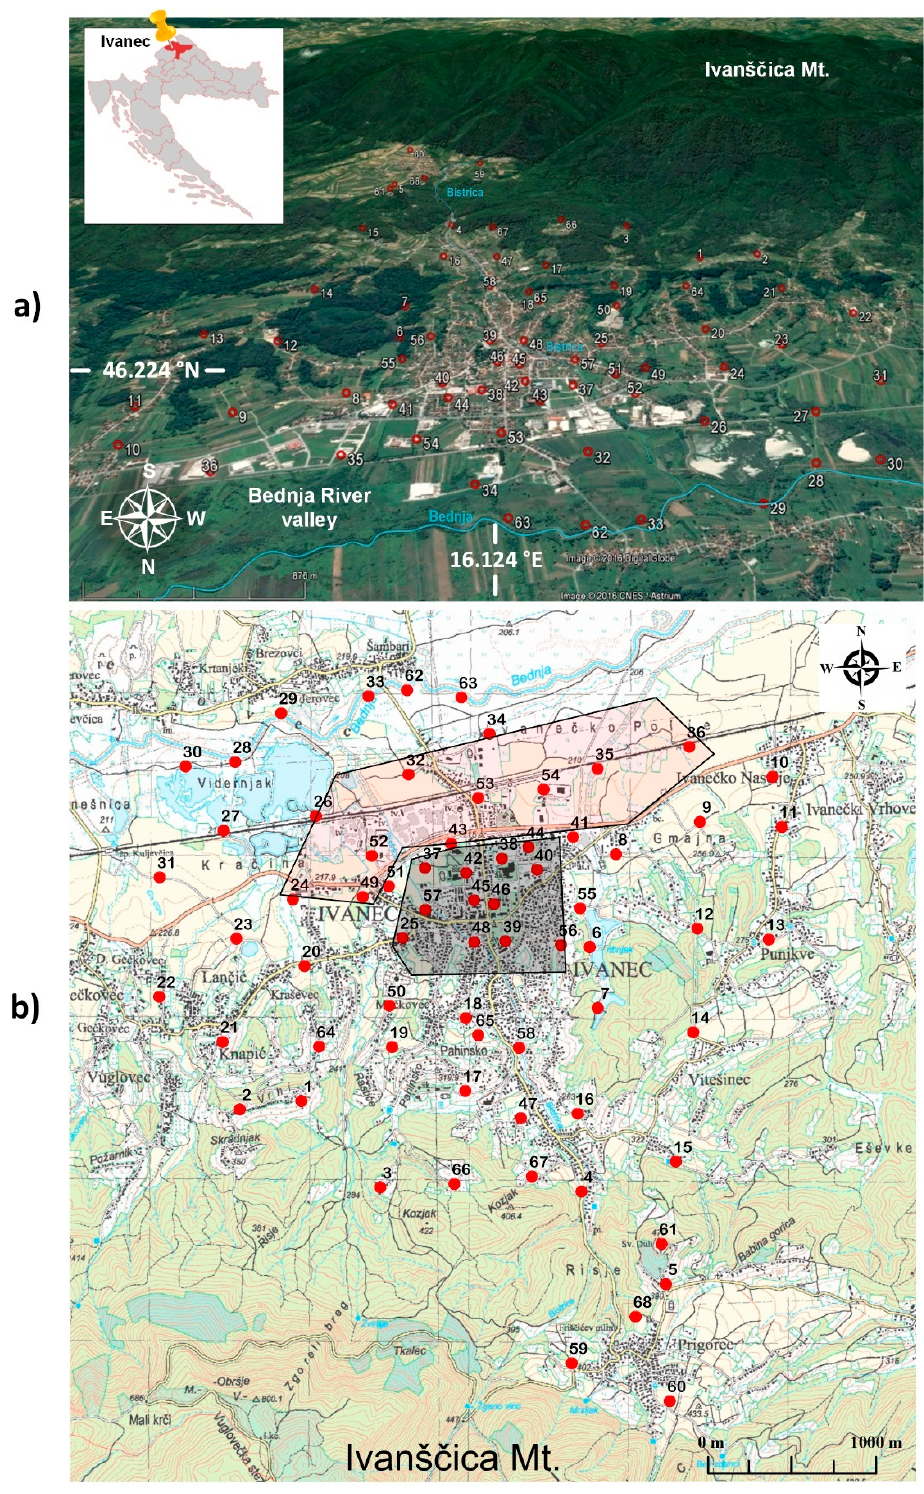
Figure 1. ( a ) Location of the City of Ivanec between Bednja River valley and Mt. Ivanš č ica. Figure is oriented to South direction to better perceive topographic terrain of the studied area and transition from Bednja River valley towards foothills of the Mt. Ivanš č ica. ( b ) Topographic map of the City of Ivanec. Red circles indicate microtremor measurement locations. Shadow areas mark industrial zone (red) and residential city central area (grey).